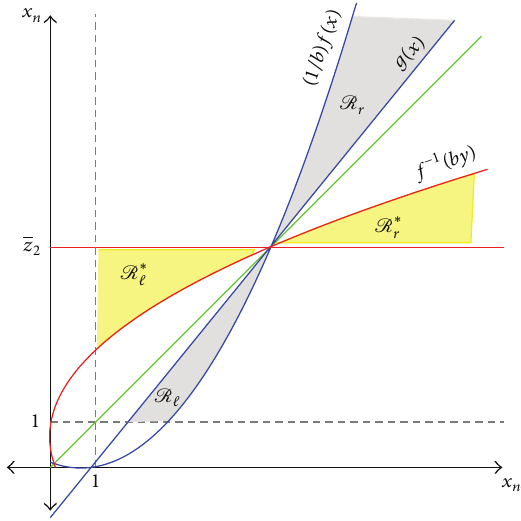
Figure 3: This figure illustrates the regions R ℓ , 𝑇( R ℓ ) = R ∗ ℓ , R 𝑟 and 𝑇( R 𝑟 ) = R ∗ 𝑟 , where 0 < ℎ <